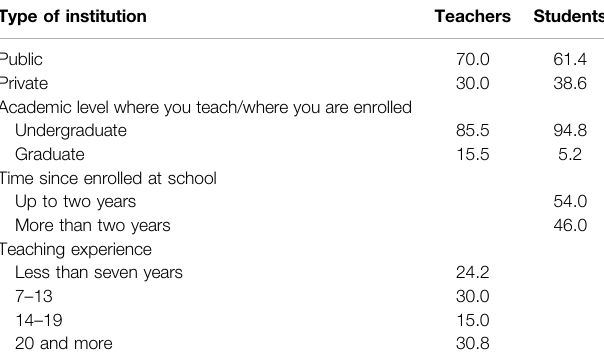
TABLE 2 | Type of institution, academic level, teacher experience time and career progression for students.